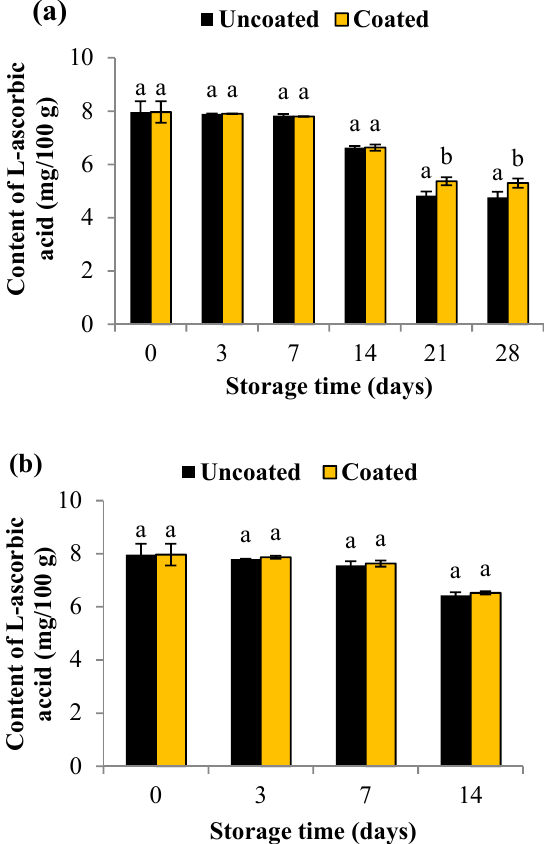
Figure 4. Content of vitamin C in uncoated and coated blueberries during storage at 4 °C for 28 days ( a ); and at 16 °C for 14 days ( b ). Error bars represent the standard deviation. Values are means of three (n = 3) replications. Means with different letters amongst different treatments for the same time are significantly different according to Tukey’s test ( p < 0.05).